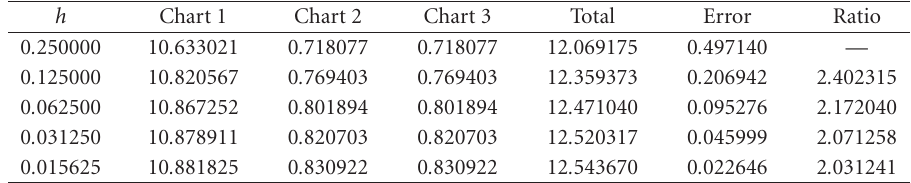
(cid:21) 1 on the unit sphere.